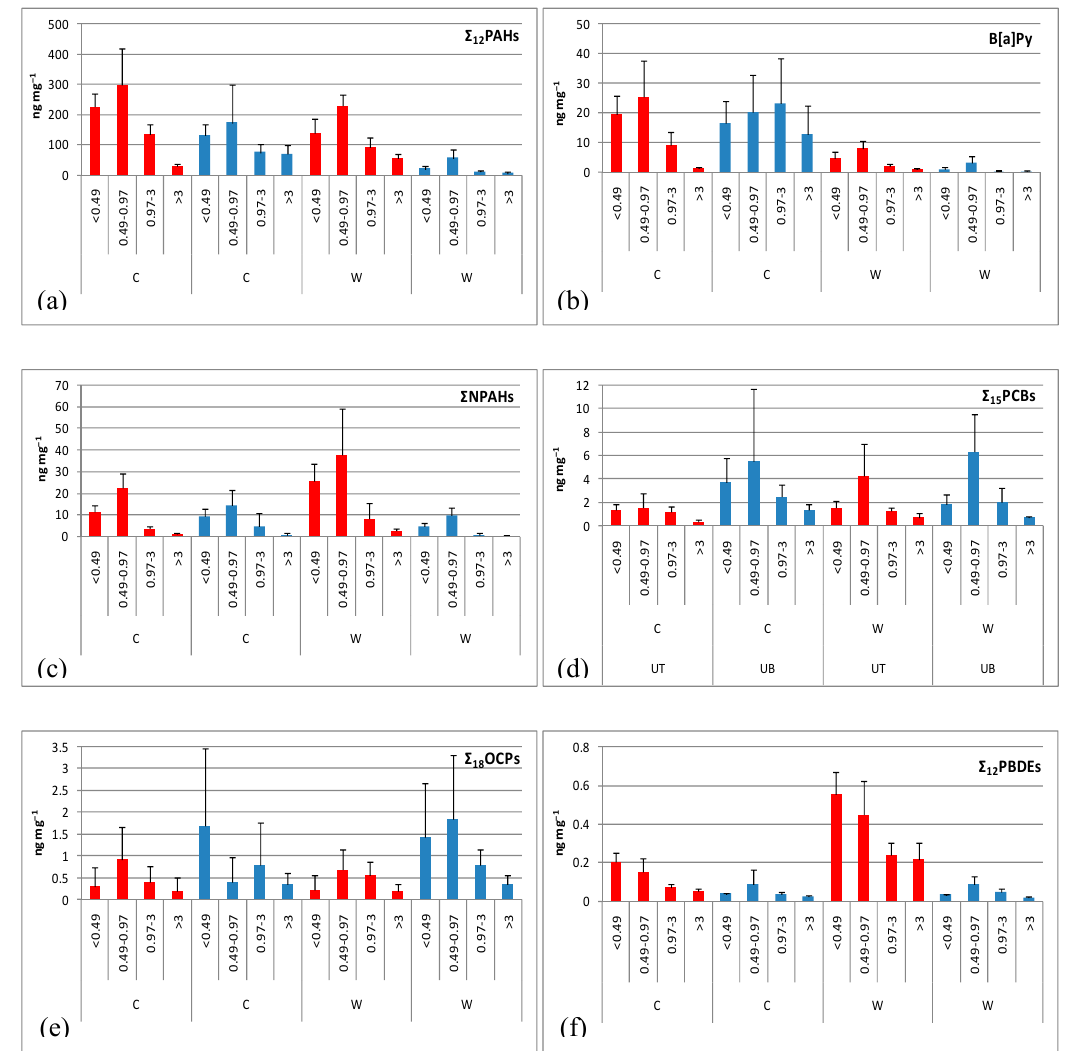
Figure 4. Mean ± SD of the content of trace organic compounds in size-segregated PM; ( a – f ) are Σ 12 PAHs, B[a]Py, Σ NPAHs, Σ 15 PCBs, Σ 18 OCPs, Σ 12 PBDEs, respectively.